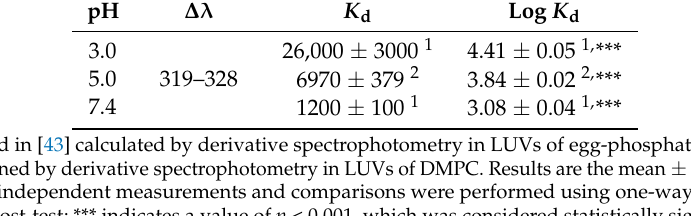
Table 1. Distribution coefficients of DCF obtained in a biphasic membrane/aqueous system.